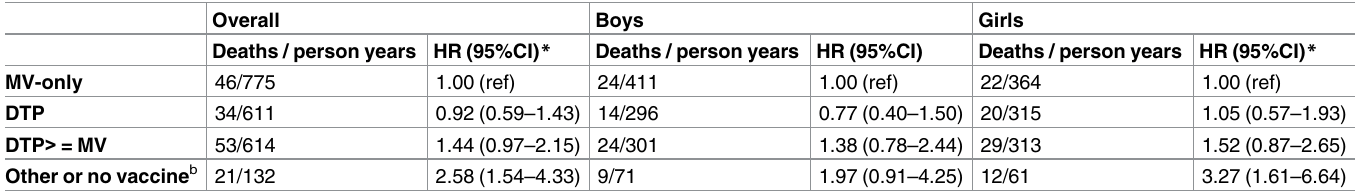
Table 4. Mortality (Hazard ratios (95%CI)) 6 months after seeing a vaccination card between 12 and 23 months according to having MV, DTP, DTP > = MV or other or no vaccine as most recent vaccination; overall and by sex a